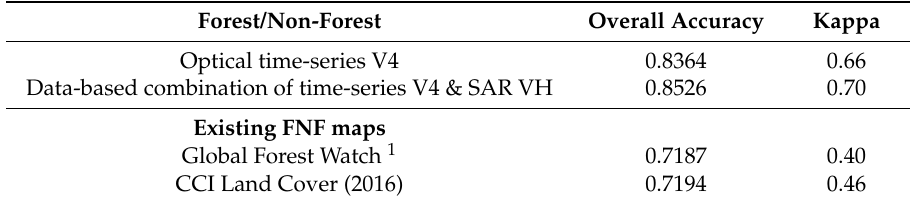
Table 8. FNF accuracy compared to existing